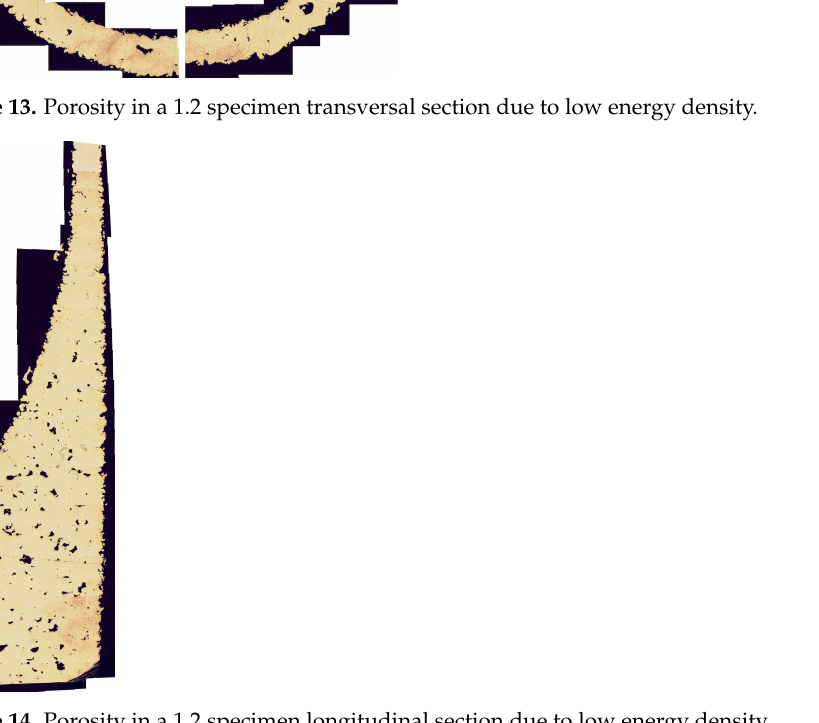
Figure 14. Porosity in a 1.2 specimen longitudinal section due to low energy